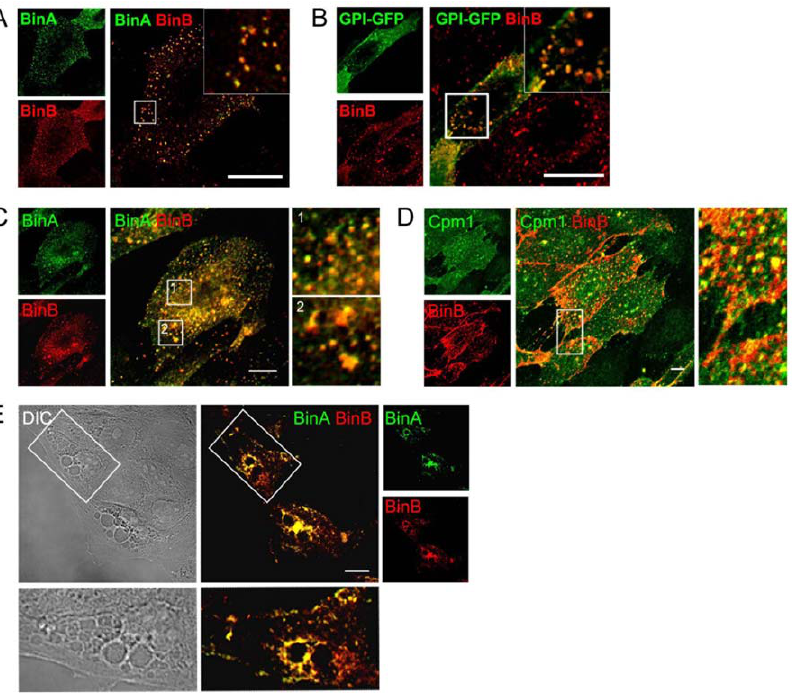
Figure 5. Internalized Bin is associated with its receptor but is not bound to vacuoles. (A, C and E) MDCK-Cpm1 cells were incubated with BinA labeled with Alexa 488 (BinA-Al 488 ) and BinB labelled with Alexa 543 (BinB-Al 543 ) at 37 u C for 10 min (A), 30 min (C) or 6h (E) and processed for confocal microscopy analysis. At any time point, BinA-Al 488 and BinB-Al 543 were found colocalized in multiple intracellular vesicles. (B) Cells transfected with GPI-GFP and treated for 10 min with unlabelled BinA and BinB-Al 543 . Vesicles positive for BinB-Al 543 were also stained by GPI-GFP. (D) Immunodetection of Cpm1 in MDCK-Cpm1 cells treated for 30 min with unlabelled BinA and BinB-Al 543 . Cpm1 signal and BinB-Al 543 labeled vesicles were found colocalized. (E) BinA-Al 488 and BinB-Al 543 -containing vesicles were found clustered between the vacuoles but not decorating the membrane of these vacuoles nor inside. Bars, 5 m m.